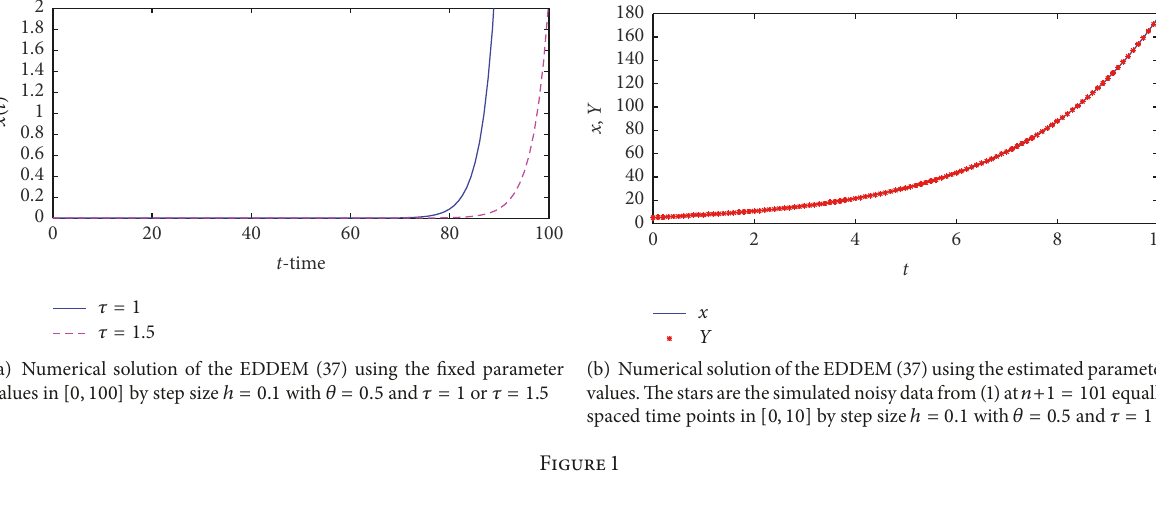
(b) NumericalsolutionoftheEDDEM(37)usingtheestimatedparameter values.Thestarsarethesimulatednoisydatafrom(1)at 𝑛+1 = 101 equally spaced time points in [0,10] by step size ℎ = 0.1 with 𝜃 = 0.5 and 𝜏 = 1